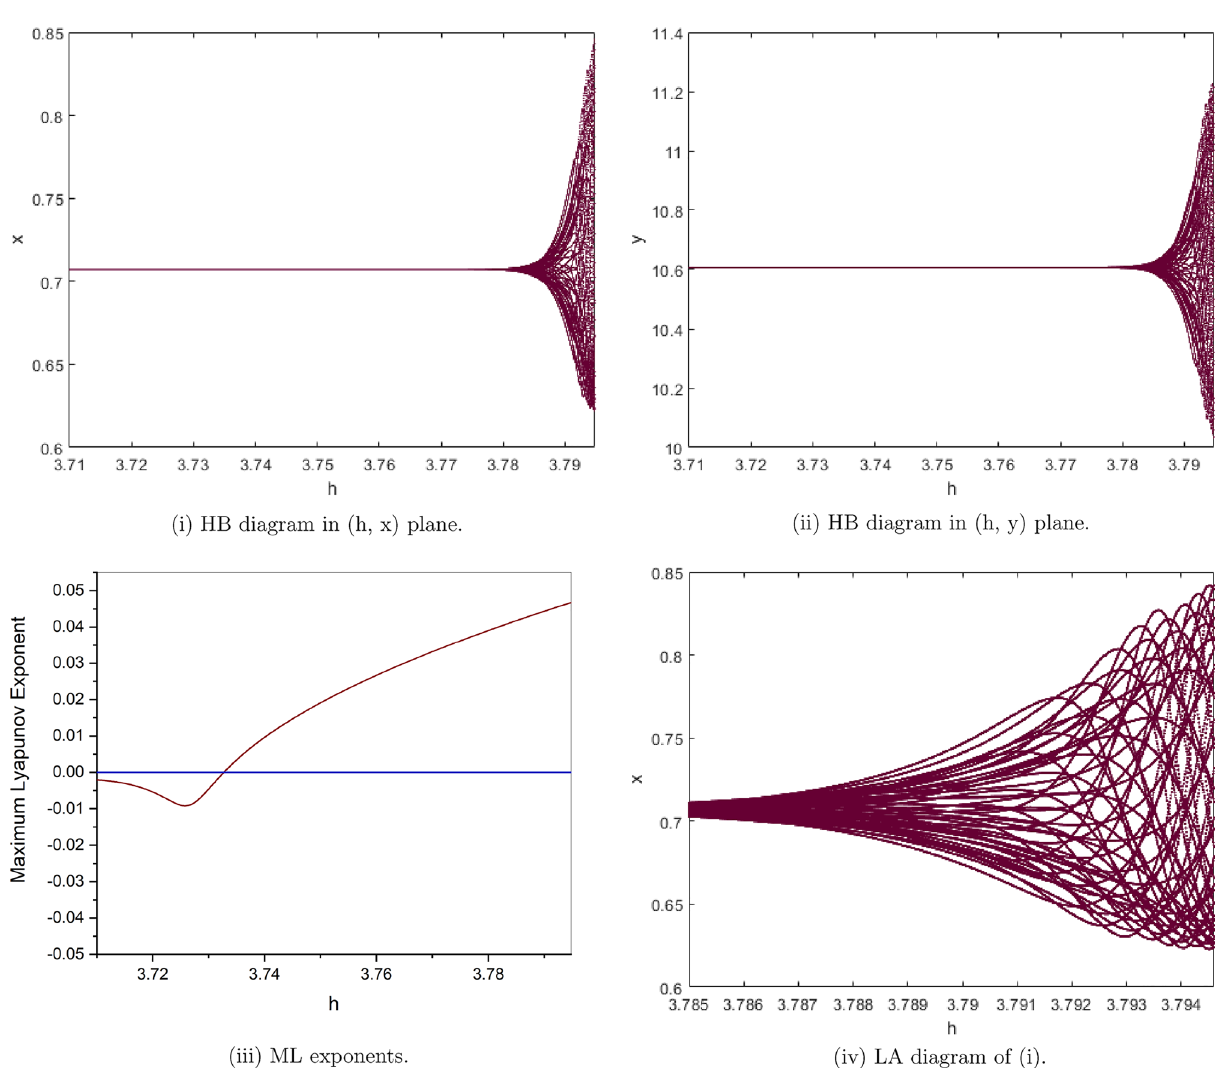
Figure 8. Bifurcation diagrams and ML exponents for the model (i) for values of a = 1.5, b = 0.5, c = 0.1, e = 2, h ϵ [3.71, 3.7948] and LA corresponding to (i) for h ϵ [3.785,